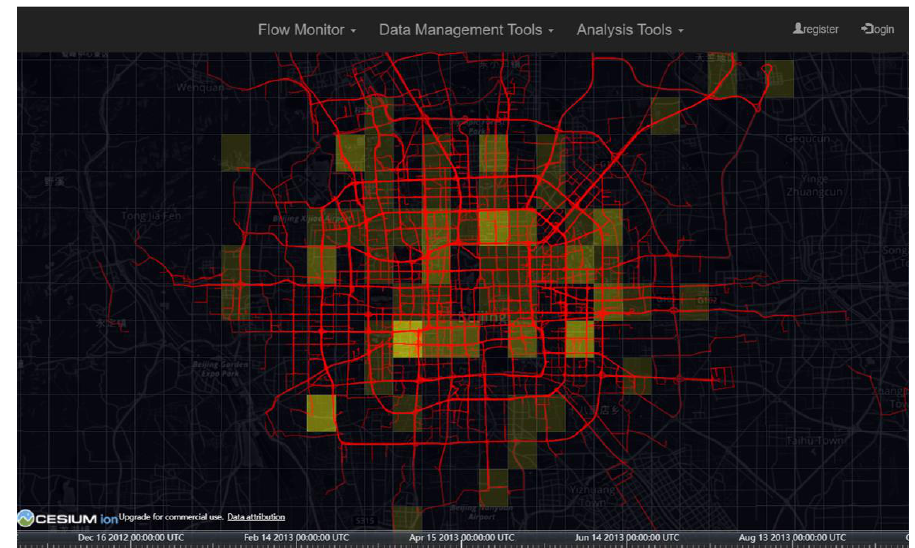
Figure 3. Interface of trajectory data management and analysis prototype system based on STGM